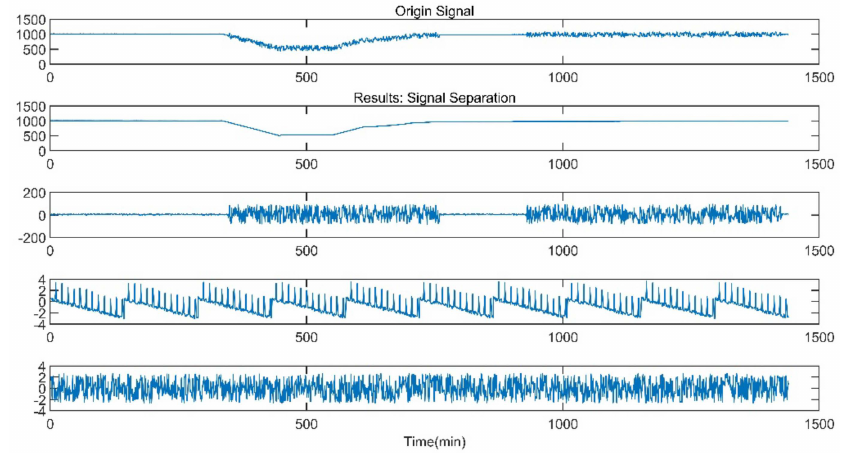
Figure 10. Separation Result of Precision Degradation